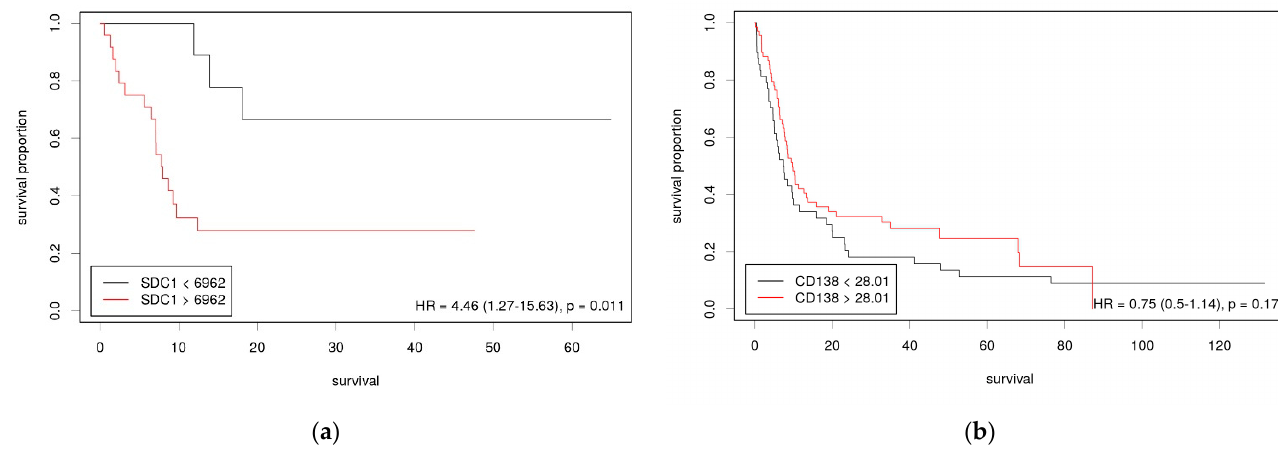
Figure 3. Kaplan–Meier curves for disease-free survival of cholangiocarcinoma ( a ) and recurrence-free survival of intrahepatic cholangiocarcinoma ( b ). Patients stratified by ( a ) SDC1 mRNA expression (TCGA cohort; n = 36) and ( b ) syndecan-1 immunohistochemical expression level (own cohort; n = 122). x -axis: time in months ( a , b ).